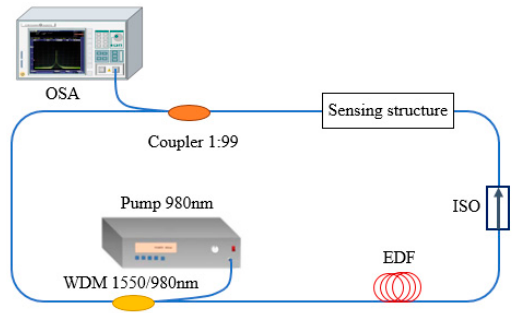
Figure 1. The schematic diagram of fiber ring laser (FRL).